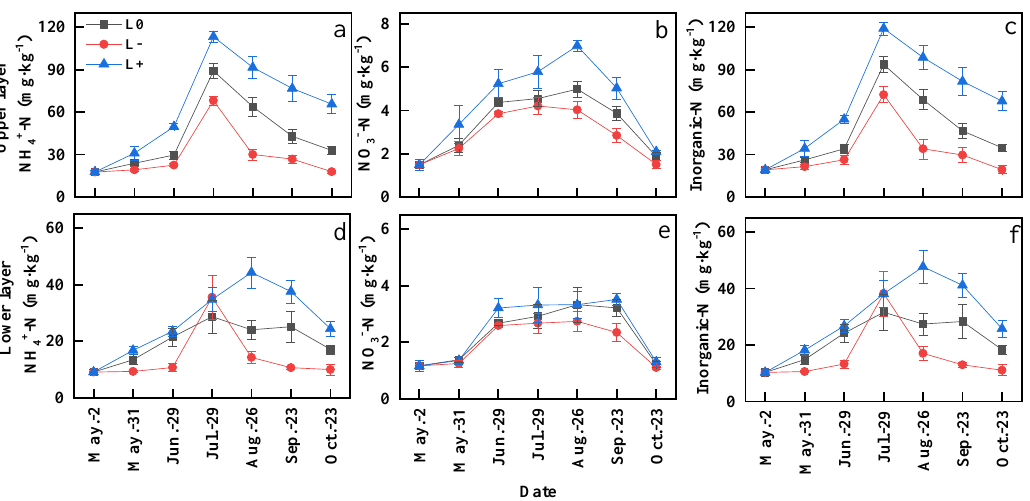
Figure 4. Monthly dynamics of the contents of soil NH 4+ -N, NO 3 − -N, and inorganic N of different litter manipulation in varied soil layers of the Larix gmelinii forest ( n = 9). Table 3. Average soil NH 4+ -N, NO 3 − -N, inorganic N, MBC, MBN contents, and MBC/MBN ratio over the sampling time under different litter manipulations in varied soil layers of the Larix gmelinii forest